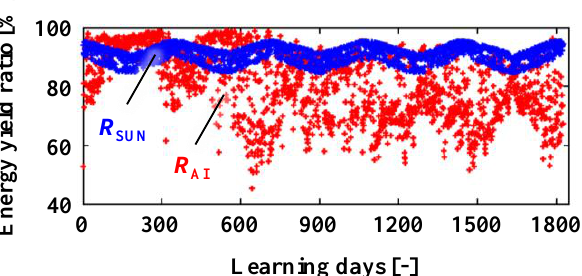
Figure 13. Variation of daily energy-yield ratio when applying a conversion efficiency degradation rate of − 10%/year (albedo = 0.5, RUN 1).